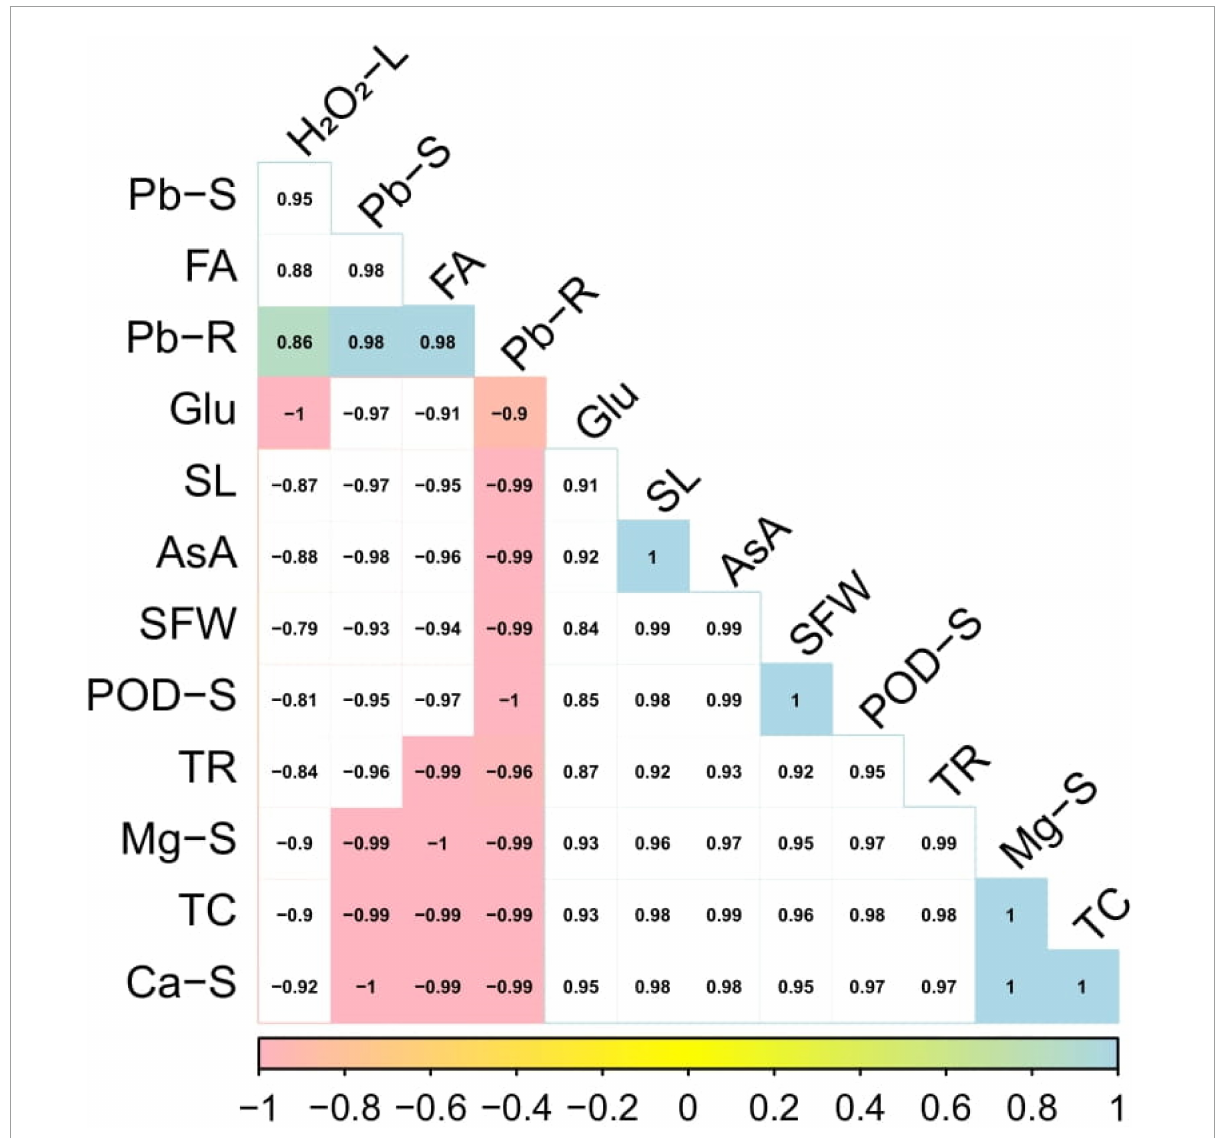
FIGURE8 Relationship of various growth attributes of Solanum lycopersicum (Cchaus) with Pb uptake under various application levels of syringic acid grown in Pb-contaminated soil. Different abbreviations used in the figure are as follows: Pb-S, lead concentration in the shoots; FA, fumaric acid; Pb-R, lead concentration in the roots; Glu, glucose content; SL, shoot length; AsA, ascorbic acid content; SFW, shoot fresh weight; POD-S, peroxidase activity in the shoots; TR, transpiration rate; Mg-S, magnesium content in the shoots; TC, total chlorophyll content; and Ca-S, calcium content in the